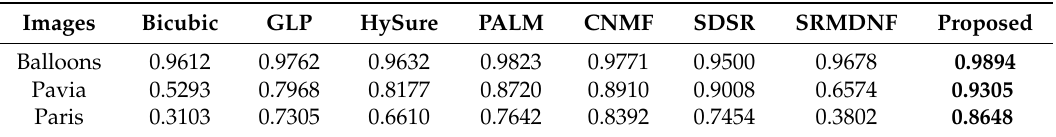
Table 4. The MSSIM values obtained by different methods on the Balloons, Pavia, and Paris images with a magnification factor of 3.